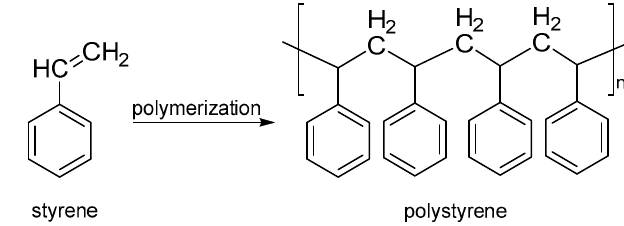
Figure 6. Synthesis of PS.